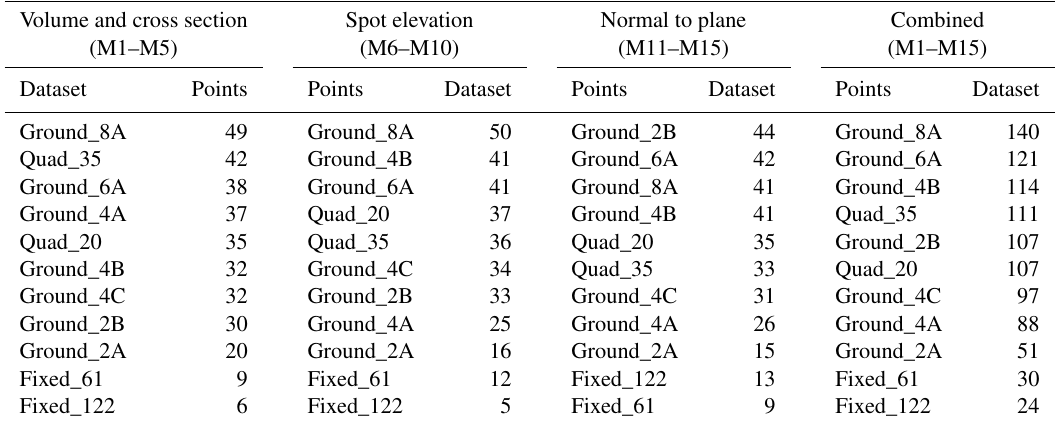
Table 8. Results from the ranking analysis based on the difference metrics of multiple photogrammetric surveys applied to gully channel